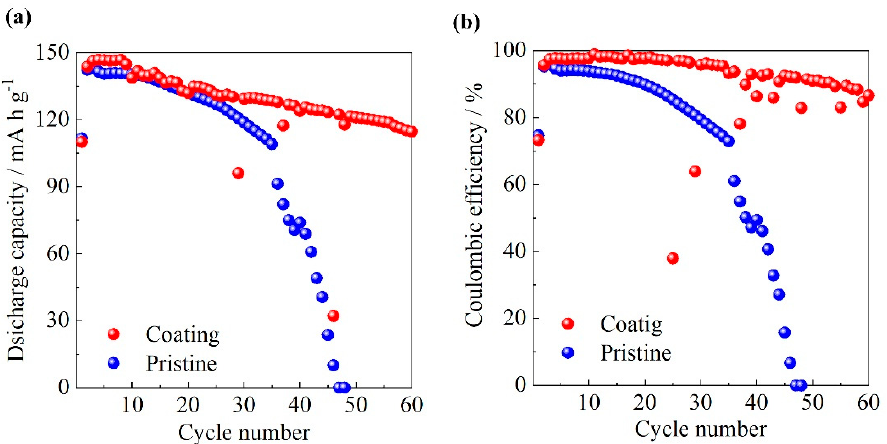
Figure 6. ( a ) Discharge capacities and ( b ) coulombic efficiencies of Li/NMC cells containing [C 3 mpyr] [FSA] over 60 cycles in the cut-off voltage range of 3.0–4.6 V at 60 °C (Charge/discharge rate: 0.5 C).